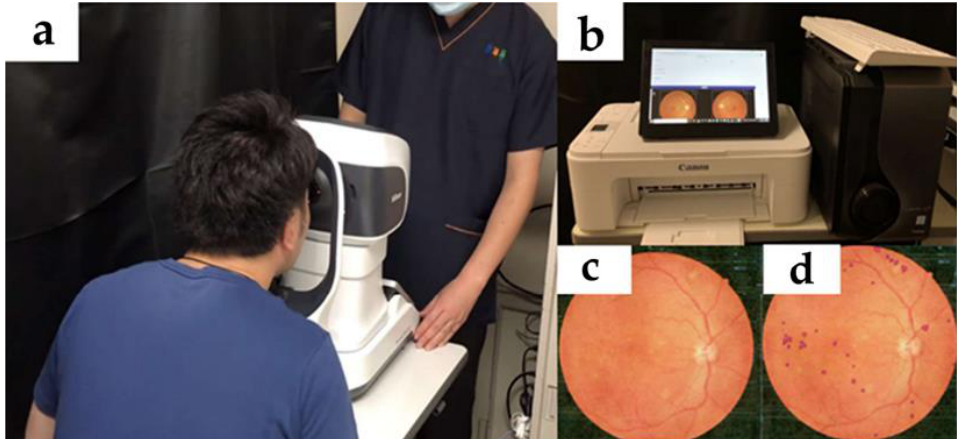
Figure 1. Photographs of the fundus and AI analysis. ( a ) Nonmydriatic fundus camera (RetinaSta- tion, Nikon, Japan). ( b ) Machine used for AI analysis (ELSA GeForce RTX 2070 S.A.C, ELSA Japan, Tokyo, Japan). ( c ) Image of fundus and ( d ) fundus photograph analyzed using AI to identify the areas of hemorrhage, which are marked in